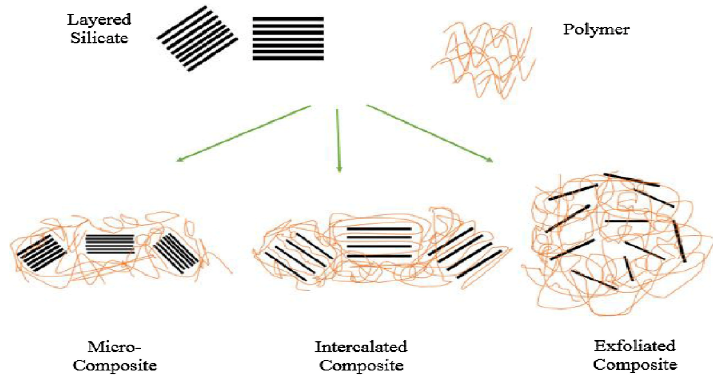
Figure 8. Assembling of polymer–clay nanocomposites through in situ intercalation, melt intercalation, and exfoliation techniques. Reprinted with permission from [96]. Copyright Elsevier,